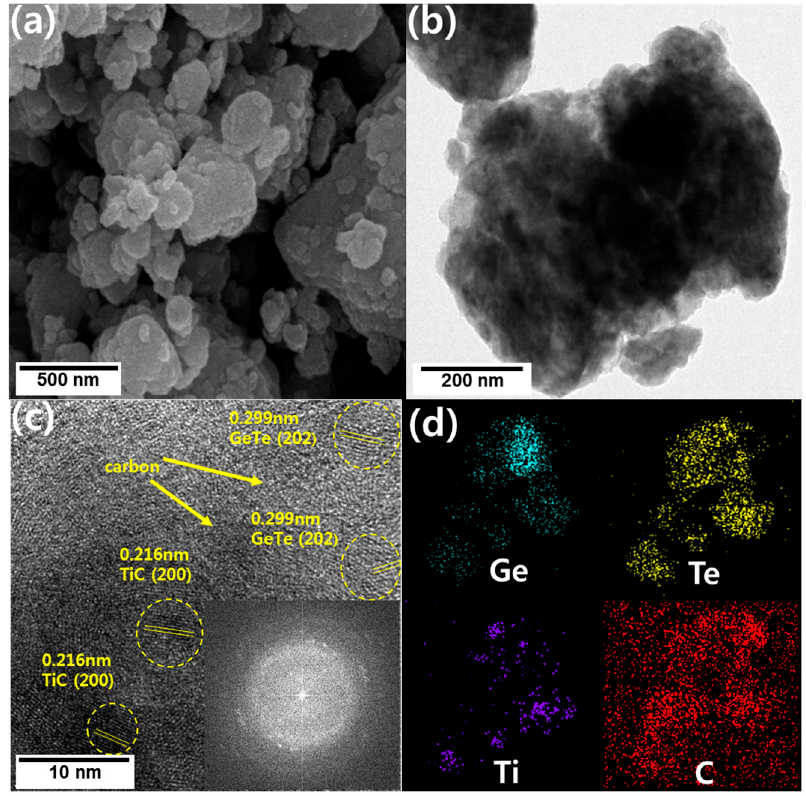
Figure 3. ( a ) Scanning electron microscopy (SEM), ( b ) Transmission electron microscopy (TEM), and ( c ) high-resolution TEM images of GeTe-TiC (20%)-C. ( d ) Energy-dispersive X-ray spectroscopy (EDS) mapping images of GeTe-TiC (20%)-C from Scanning transmission electron microscopy (STEM).